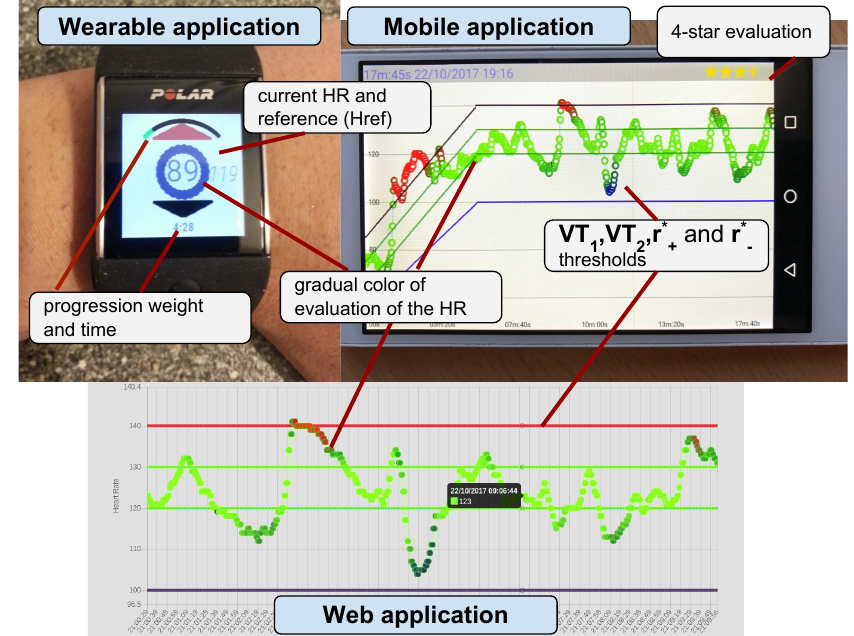
Figure 4. Pictures of the wearable, mobile, and web applications. In the wearable application in Polar M600, we show (1) a gradual color change in the evaluation of the HR; (2) progression and total time; and (3) the current and reference HR. In the mobile application, the VT 1 , VT 2 , r ∗ + and r ∗ − thresholds and the 4-star evaluations are described. In the web application, the cardiac rehabilitation team has access to heart streams and VT 1 , VT 2 , r ∗ + and r ∗ − thresholds of patients with zoom and scale